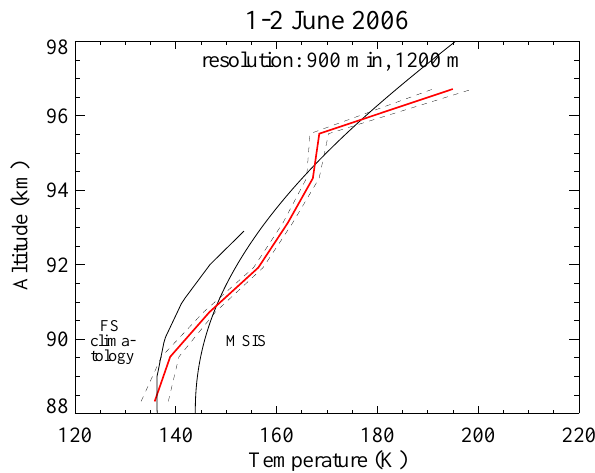
Fig. 4. The mean temperature profile for the whole measuring time is plotted as the solid red line. The dashed lines show the statistical error of the temperature. Two reference temperature profiles are also plotted, the monthly mean temperature for June (L¨ubken, 1999) and the daily temperature profile from the MSISe90 model (Hedin, 1991).